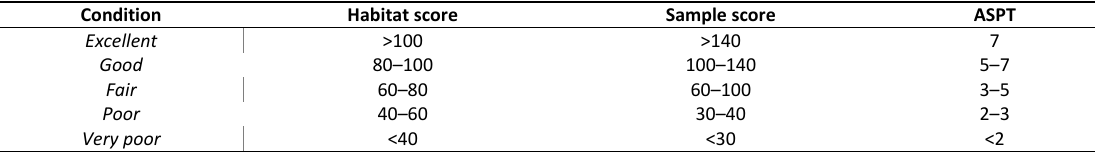
Table 4: The scores used to determine the condition of a site using SASS 5 (Ollis et al., 2006)